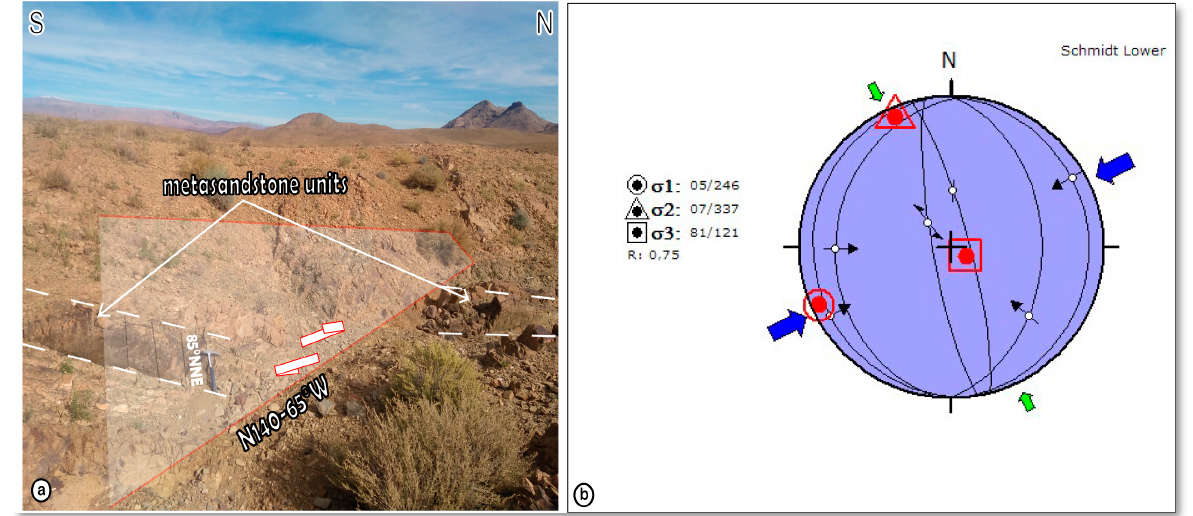
Figure 5. ( a ) Field photo showing a NW-SE strike-slip affecting the black shales units of the Saghro Group. ( b ) Stereographic projection of the fault analysis and the interpreted stress axis during the brittle deformation of the Saghro Group basement. brittle deformation of the Saghro Group